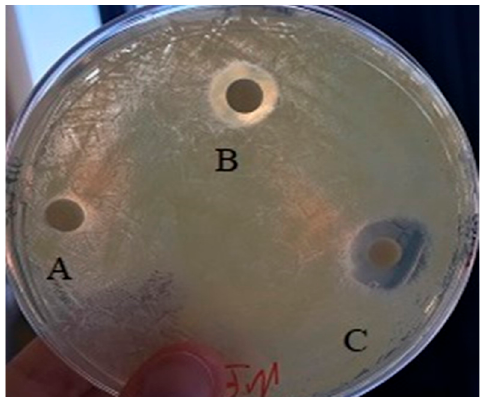
Figure 19. SeNPs’ effect against K. rhizophila. Inhibition halos obtained in the presence of 40 mg SeNP solution from medium A (spot A), from medium B (spot B), and from medium C (spot C).